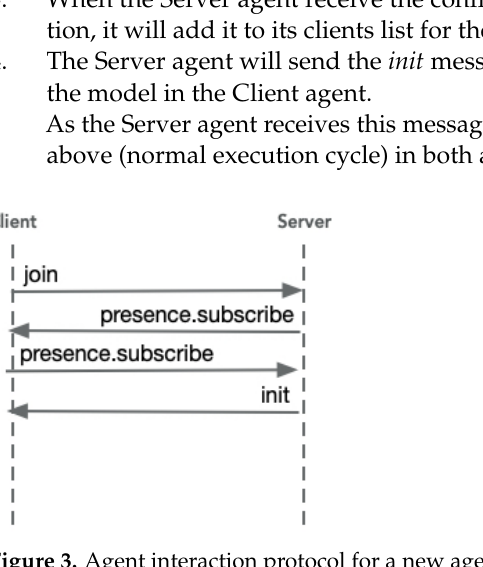
Figure 3. Agent interaction protocol for a new agent entering the